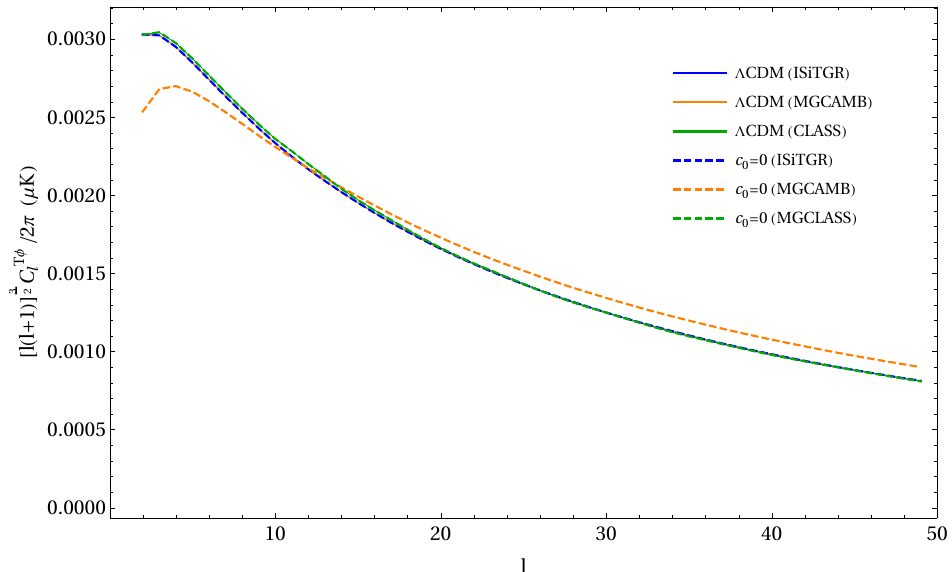
predictions between the three programs—ISiTGR (blue), MGCAMB Figure 3. Comparison of the C T φ l (orange) and MGCLASS (green)—with their corresponding patches for a modified Newton’s constant. This serves as a consistency check between the programs and a validity check for their patches. The solid curves are generated from the respective original Λ CDM programs, while the dashed curves are generated by each program’s modified Newton’s constant patch setting µ ( a , k ) G mod / G Newt = 1. ≡ It can be seen that ISiTGR is the most consistent, and hence reliable program of the three, to investigate the effects of a modified Newton’s